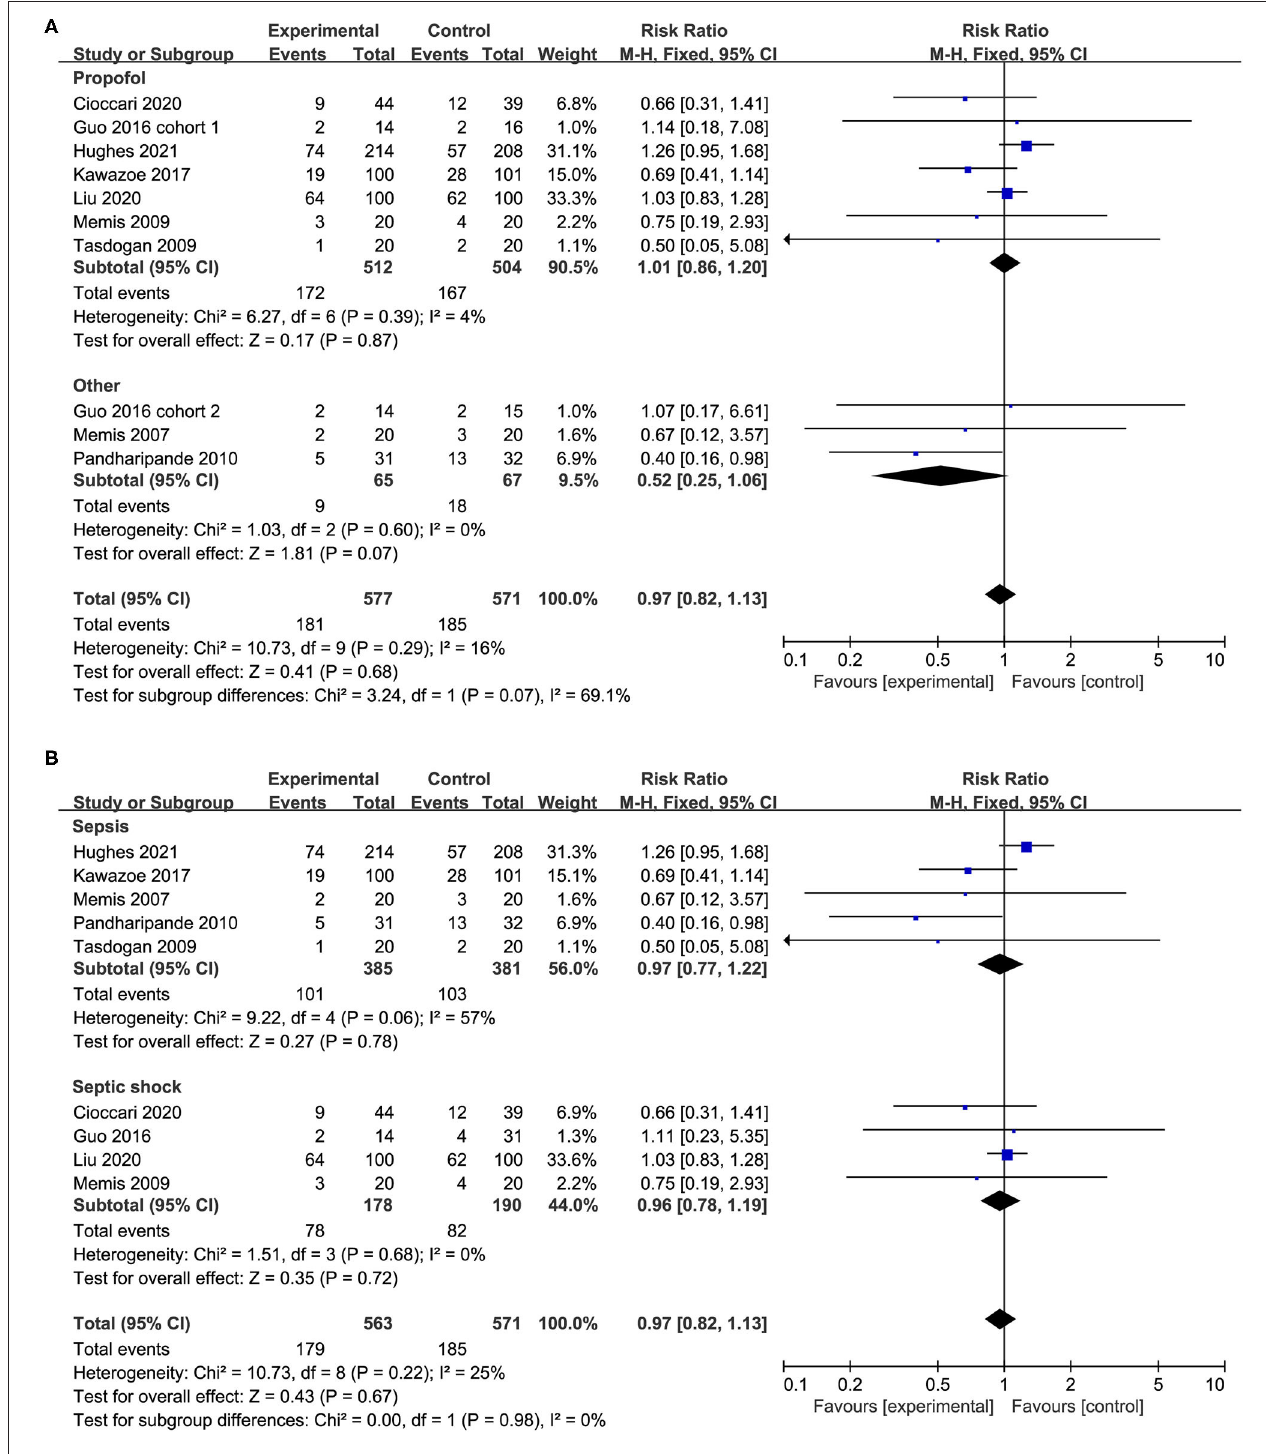
FIGURE 4 | Subgroup analysis for mortality (A) propofol vs. other sedation, (B) sepsis vs. septic shock.